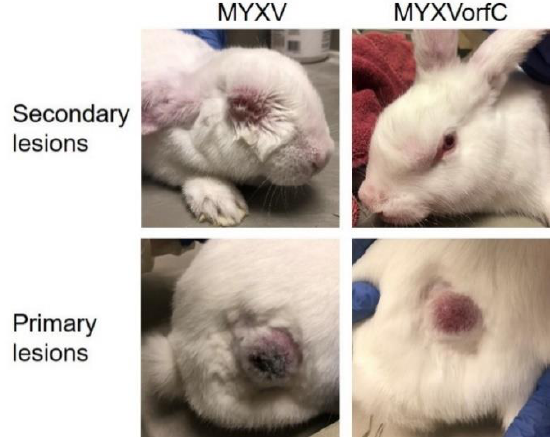
Figure 8. Representative images of gross skin lesions 9 days after intradermal inoculation of 50 pfu MYXV or MYXVorfC on the right thigh.